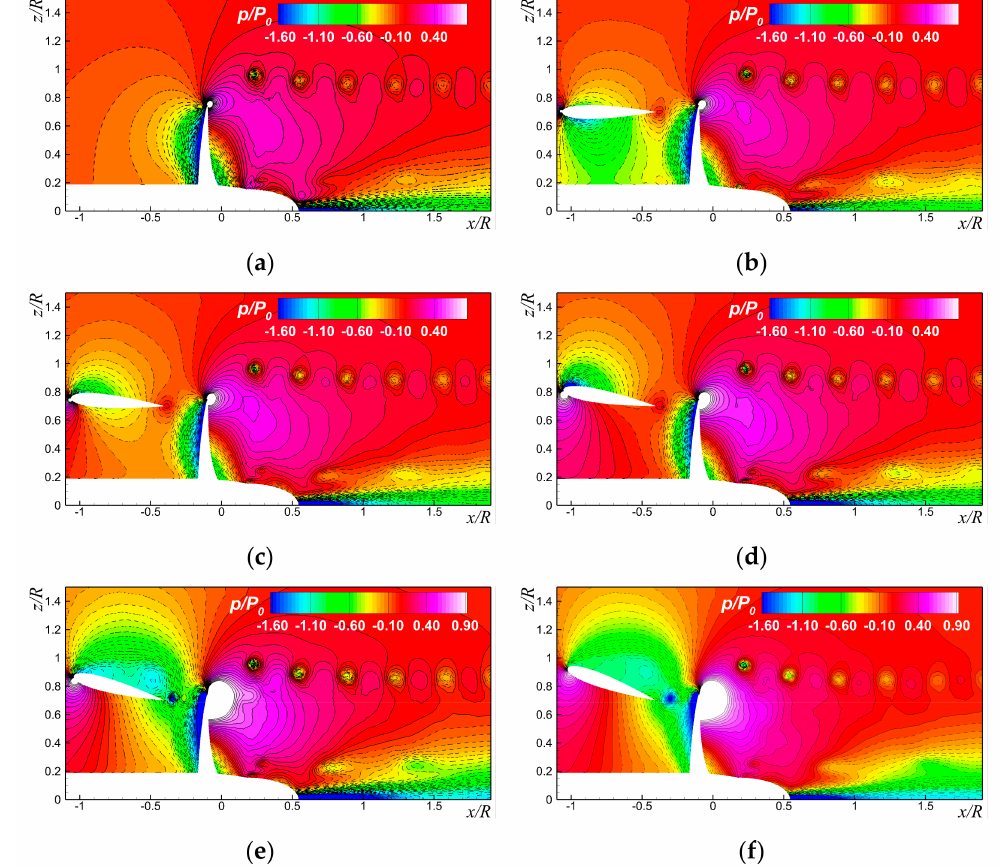
Figure 15. Contours of pressure normalized with the atmospheric pressure ( p / P 0 ) computed at J = 0.7 for the single propeller and for the propeller-duct arrangement in the longitudinal plane at D N / D = 0.7: ( a ) single propeller, ( b ) θ = 0 ◦ , ( c ) θ = 5 ◦ , ( d ) θ = 10 ◦ , ( e ) θ = 15 ◦ , ( f ) θ = 20 ◦